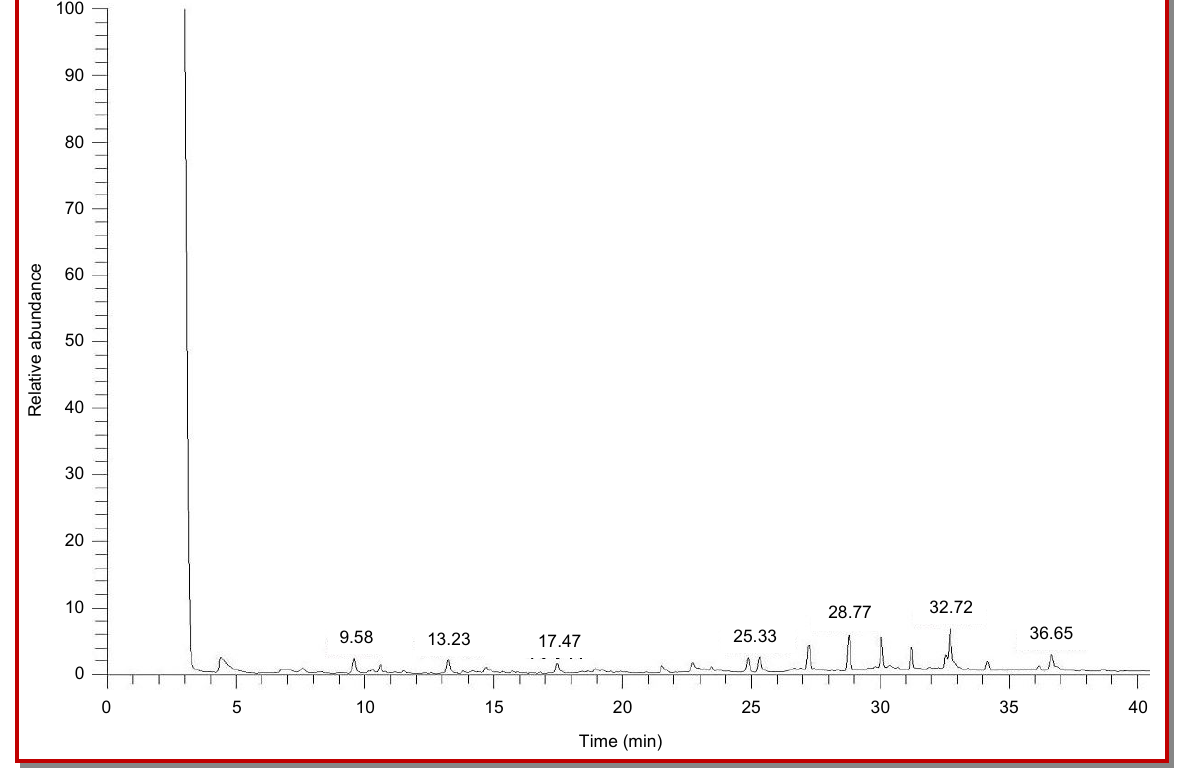
Figure 2: GC-MS chromatogram of EAE-B of Drimia